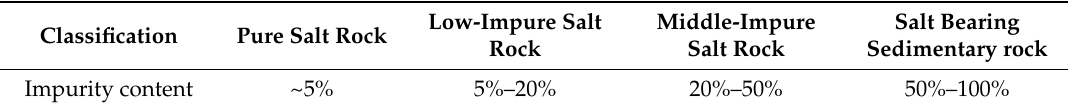
Table 1. Classification of salt rock with di ff erent impurity